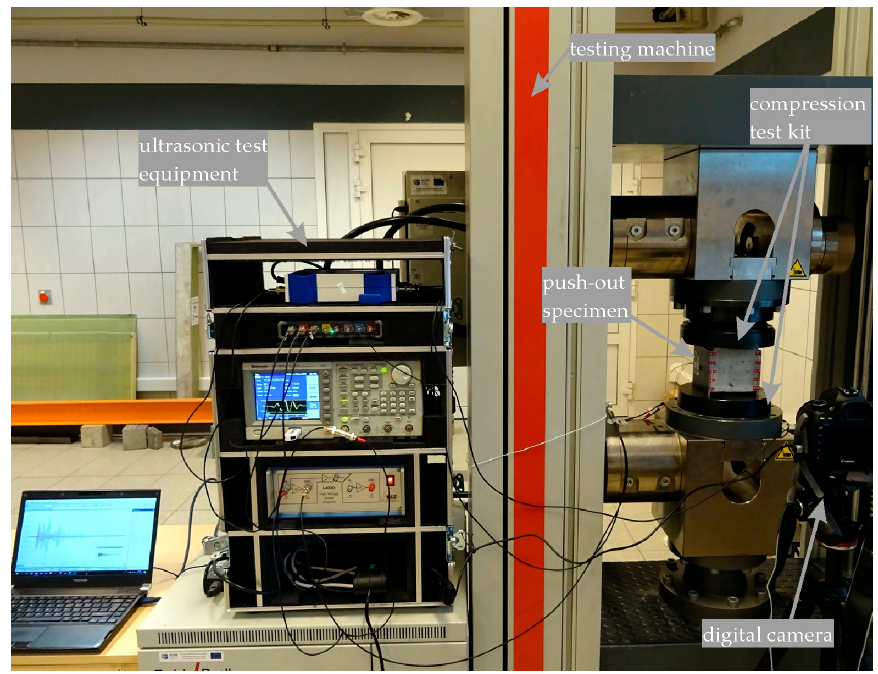
Figure 3. Experimental setup for push-out and ultrasonic tests.